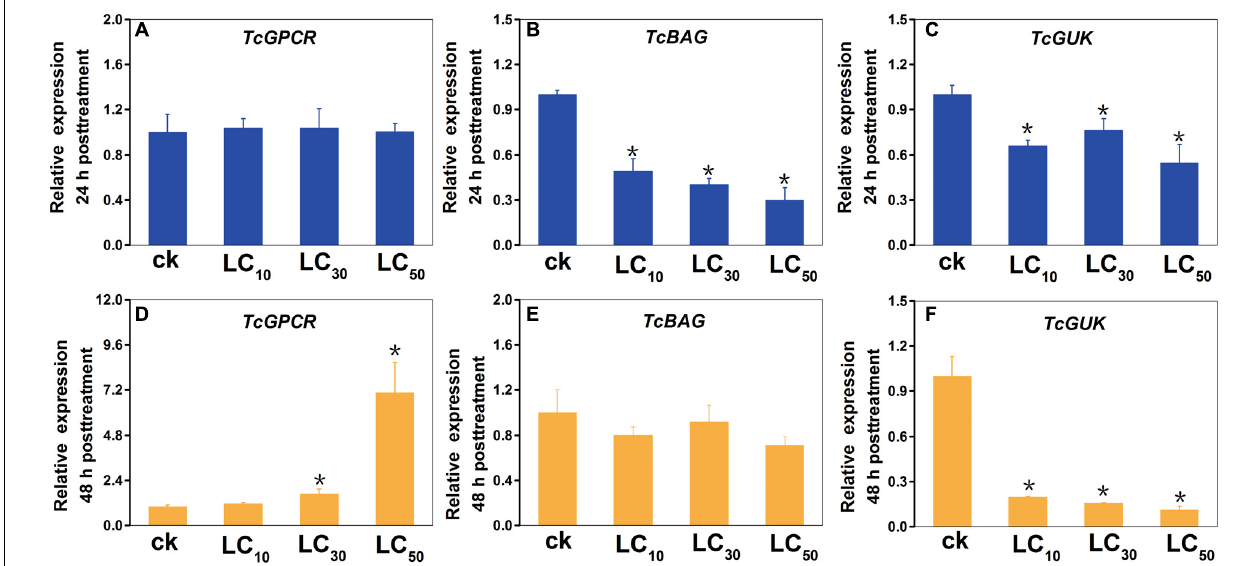
FIGURE 9 | Expression profiles of TcGPCR, TcBAG, and TcGUK transcripts after scopoletin treatment for 24 h and 48 h at three different concentrations, respectively. Relative expression of the TcGPCR (A,D) , TcBAG (B,E) and TcGUK (C,F) of T. cinnabarinus exposed to 0.099, 0.374, and 0.938 mg/L scopoletin (LC 10 , LC 30 , and LC 50 ) in 0.1% (v/v) Tween-80 and 3% (v/v) acetone at the adult stage for 24 and 48 h using a slip-dip bioassay were analyzed using RT-qPCR, respectively. Error bars represent the standard error of the calculated mean based on three biological replicates. Water containing 0.1% (v/v) Tween-80 and 3% (v/v) acetone was used as the control treatment (CK). An asterisk ( ∗ ) on the error bar indicates a significant difference between the treatment and group (CK) according to t -tests, ∗ p < 0.05. RPS18 was used as the reference gene.